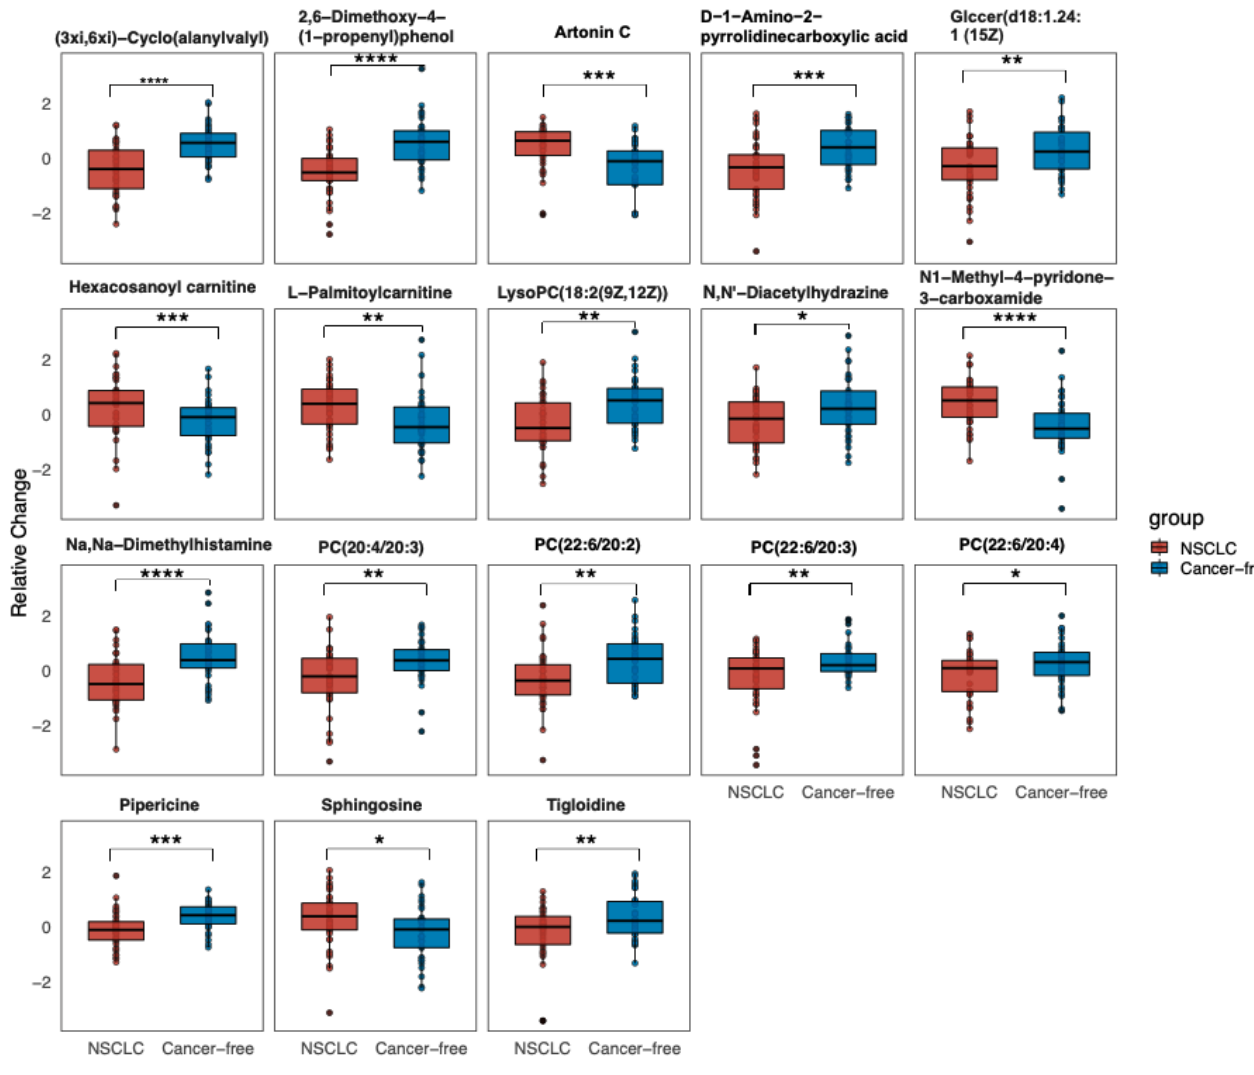
Figure 4. Relative abundance of 18 significantly changed metabolites across the groups (the relative expressed values were compared using a Student’s t -test). Data are the normalized values by log-transformation and UV scaling. The presented box shows the 25th and 75th percentiles. The horizontal line represents the mean values of each metabolite. p < 0.05, *; 0.001 < p < 0.01, **; 0.0001 < p < 0.001, ***; p < 0.0001, ****. Abbreviation: GlcCer: Glucosylceramide; PC: Phosphatidylcholine; LysoPC: